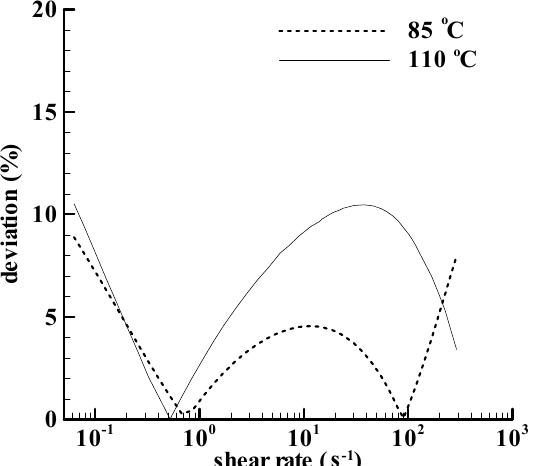
Figure 4. The deviations between the N 1 calculations with the power law strain model and those with the linear strain model for two kinds of corn starch dispersions. One is heated to 85 °C in the Rotavapor, and the other is in cans at a retort temperature of 110 °C.